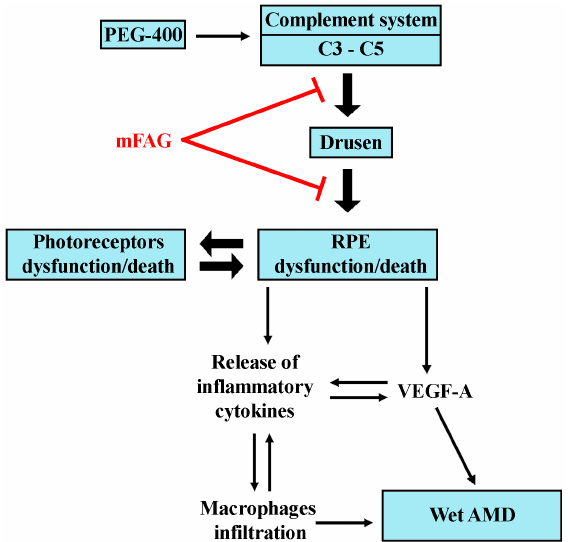
Figure 7. Schematic diagram depicting a possible mechanism of action of mFAG. mFAG, by interfering with complement-mediated activation of RPE cells, would modulate the synthesis and secretion of AMD-associated cytokines and reduce macrophage infiltration in the retina and the choroid, thus preventing or limiting the progression of AMD to the wet form.